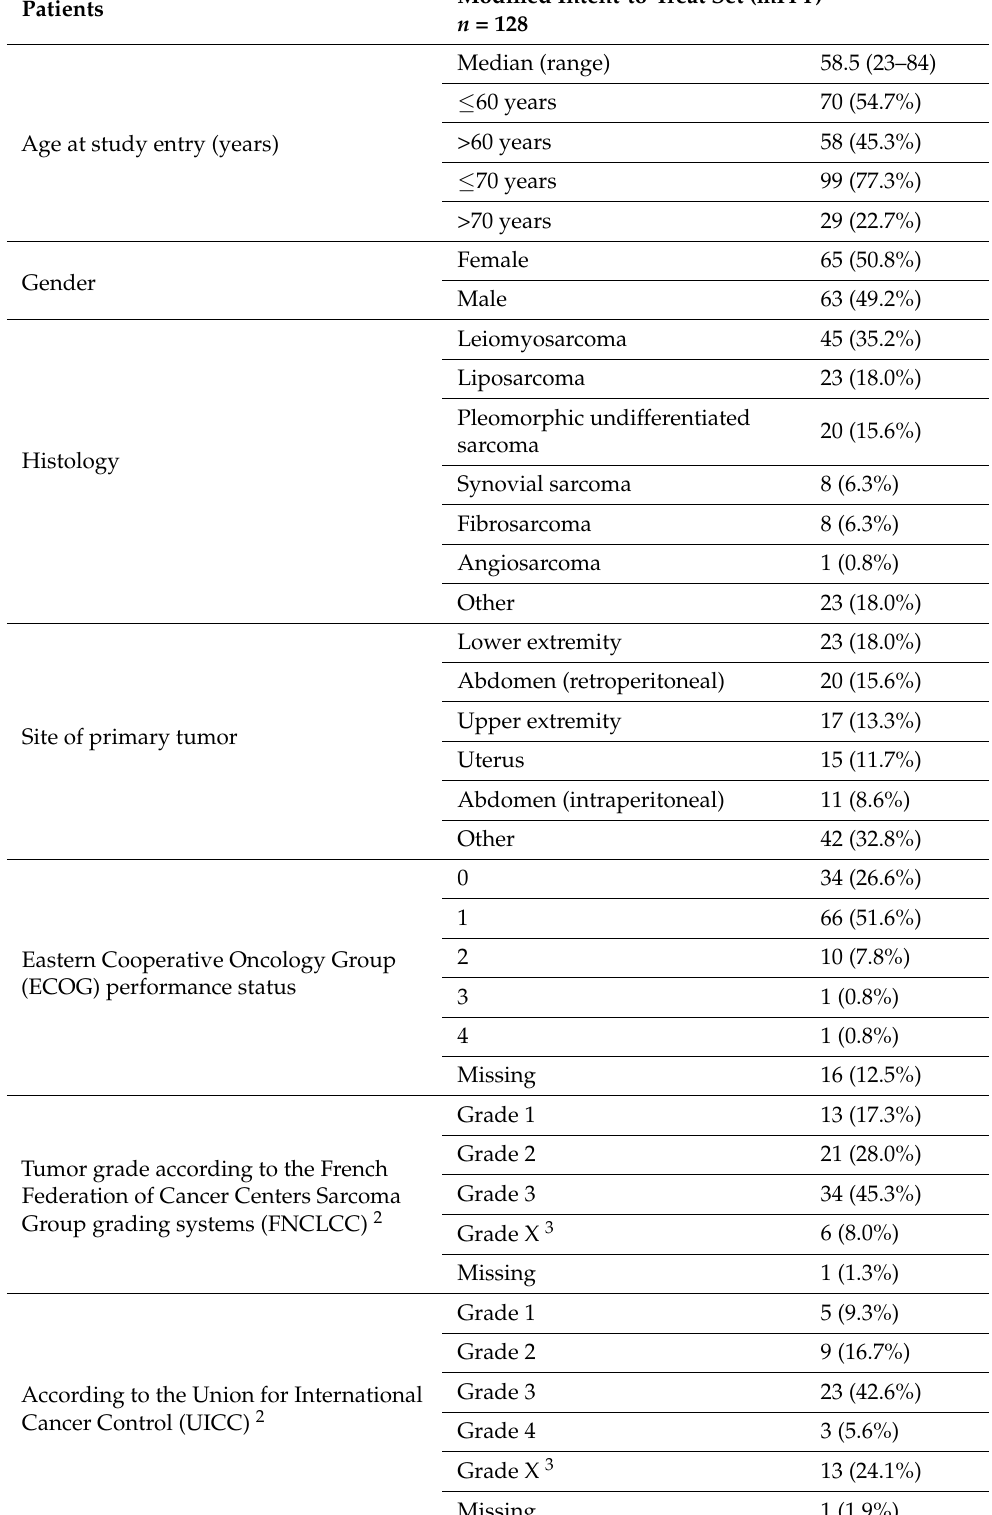
Table 1. Patient and disease characteristics at